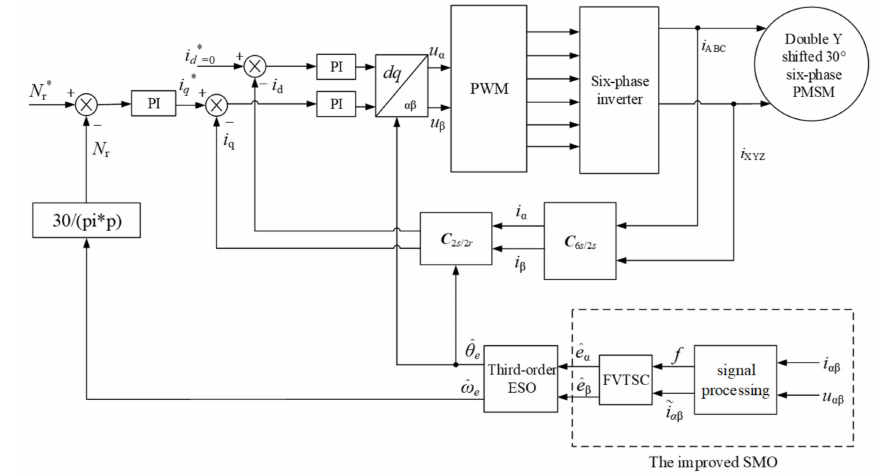
Figure 8. Sensorless control system block diagram of dual Y shift 30 ◦ six-phase